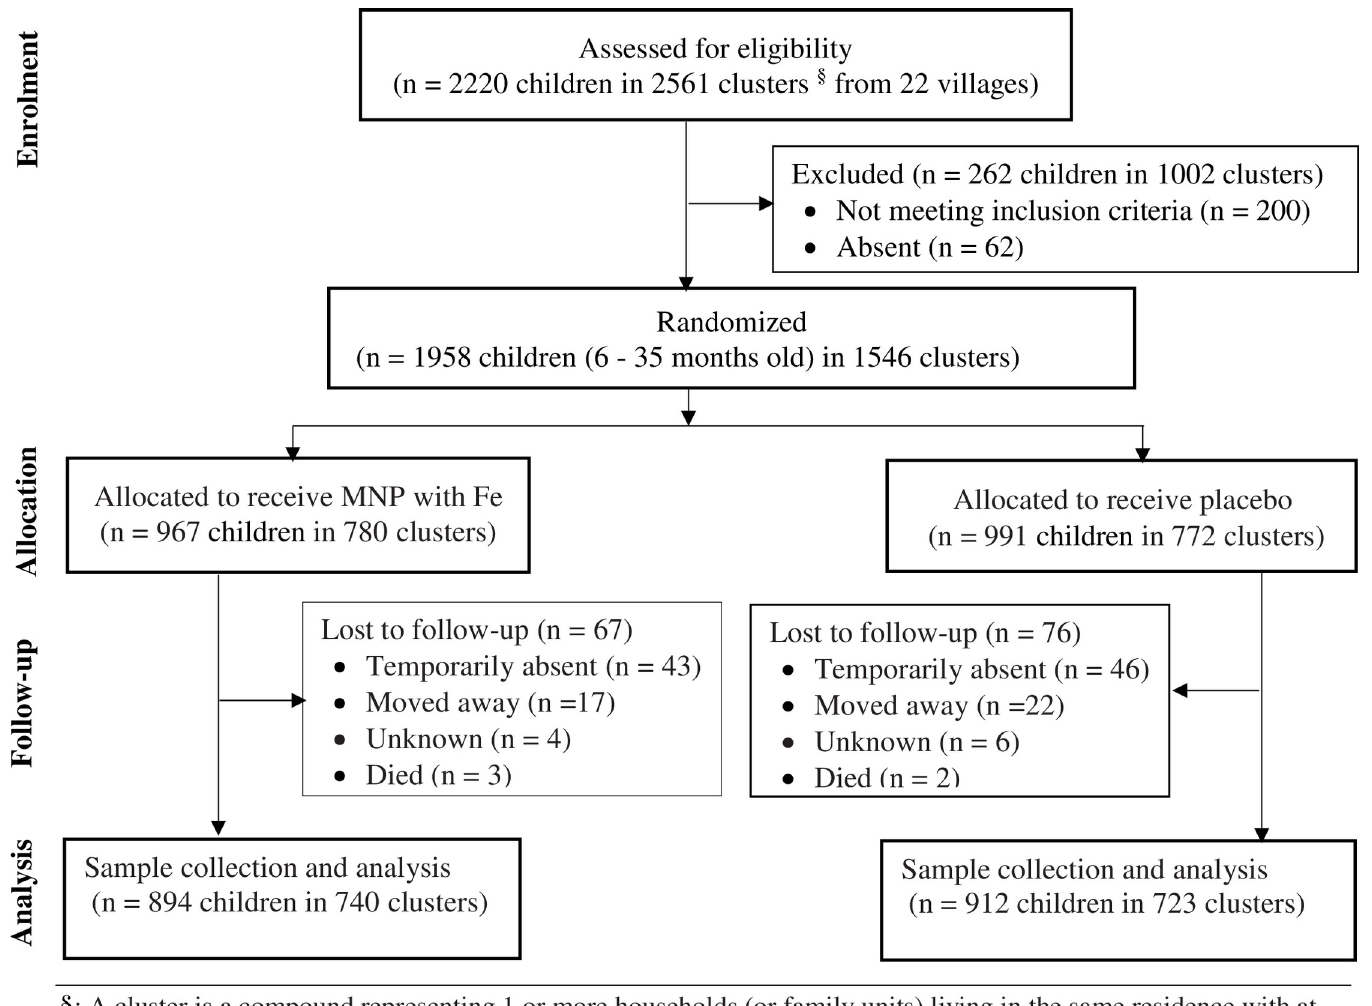
Fig 1. Study profile. Micronutrient powder (MNP), Fe (iron), Children (CHN), Month (mo), Number (n). §: A cluster is a compound representing 1 or more households (or family units) living in the same residence with at least 1 eligible child enrolled in the study.